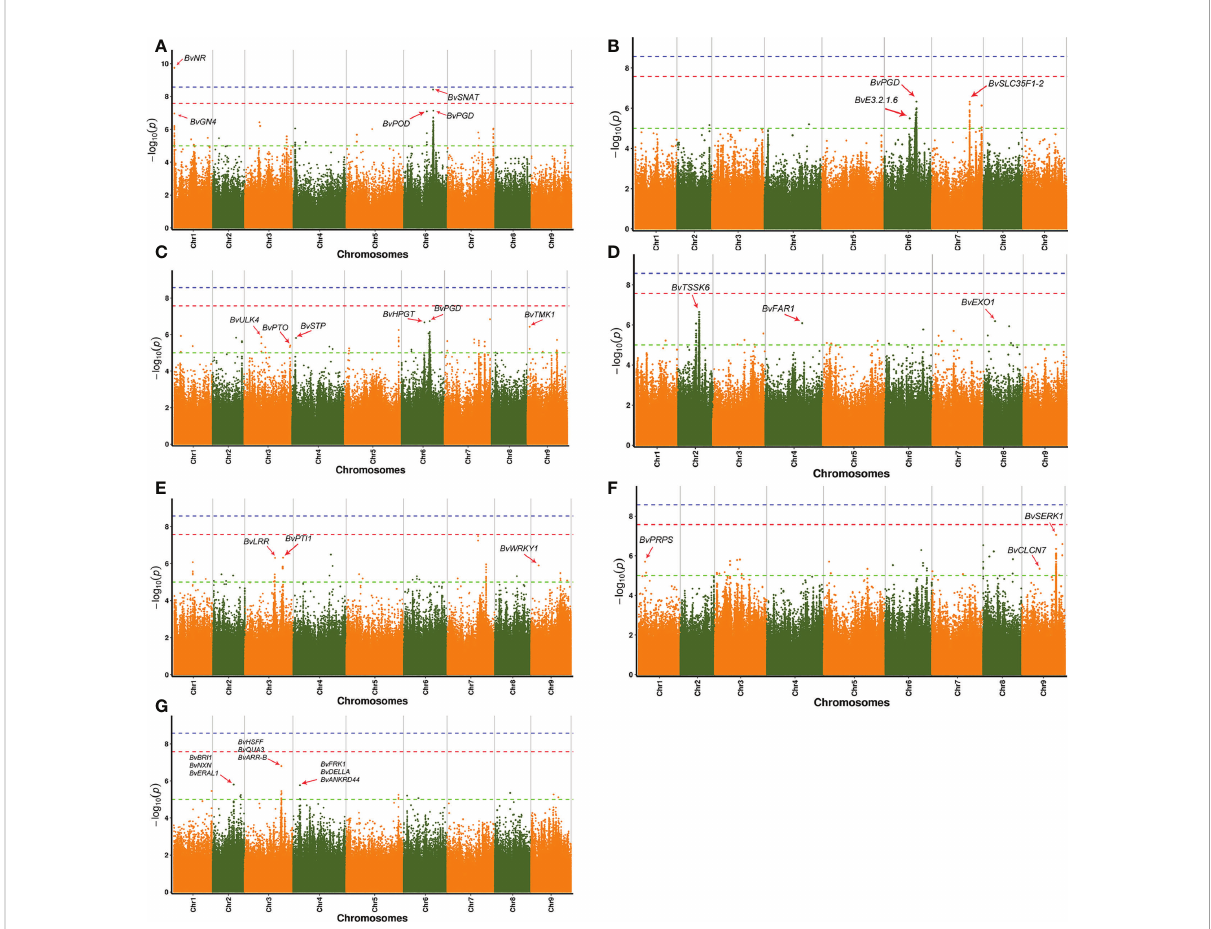
FIGURE 6 Manhattan plots for seven agronomic traits of 114 sugar beet lines. (A) Sugar content, (B) sugar yield per hectare, (C) root yield per hectare, (D) root rot of sugar beet, (E) damping off of sugar beet, (F) rhizomania of sugar beet, and (G) pollen fertility of sugar